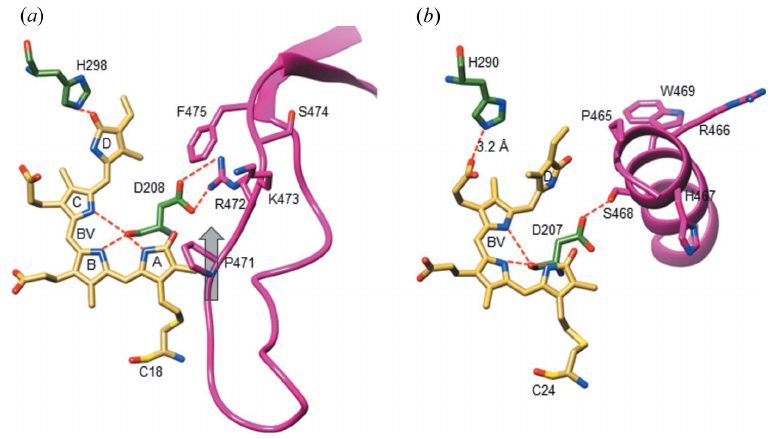
Figure 9 The chromophore and sensory tongue region of the SaBphP1-PCM in the Pr conformation compared with the DrBphP-PCM in the Pfr form. Residues that are considered essential for the Pr to Pfr transition are marked. Red dotted lines: interactions of important residues. ( a ) Chromophore region of the SaBphP1-PCM, BV ring D is in the Z -configuration. Gray arrow, direction of the structural displacement of P471 from Pr to Pfr. ( b ) Chromophore region of the DrBphP-PCM F469W mutant (Burgie et al. , 2016), ring D is in the E -configuration. H290 interacts with the ring D propionate. Note, compared with the published structure, the His290 ring was rotated by 180 (cid:6) about the (cid:8) 2 angle to motivate the interaction. The DrBphP residues Ser468, Arg466 and Pro465 correspond to Ser474, Arg472 and Pro471 in SaBphP1, respectively (see also Fig. 4 for absorption spectra of specific